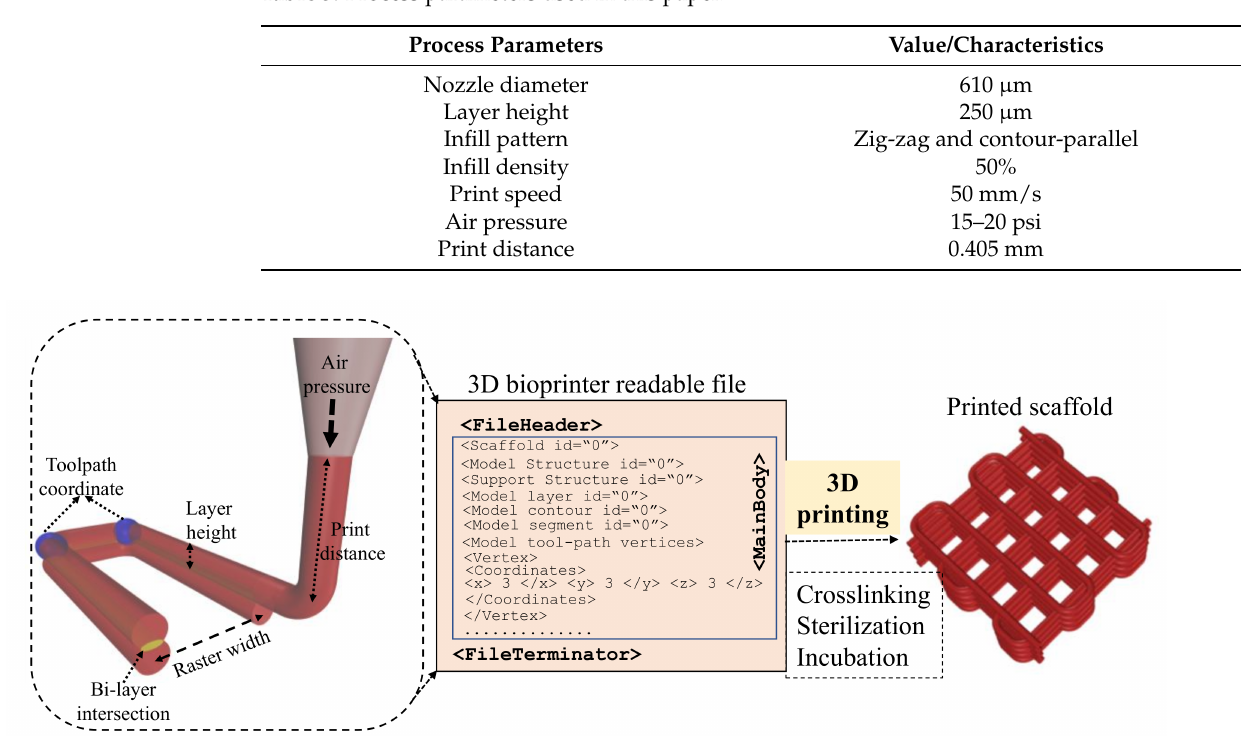
Table 3. Process parameters used in this paper.